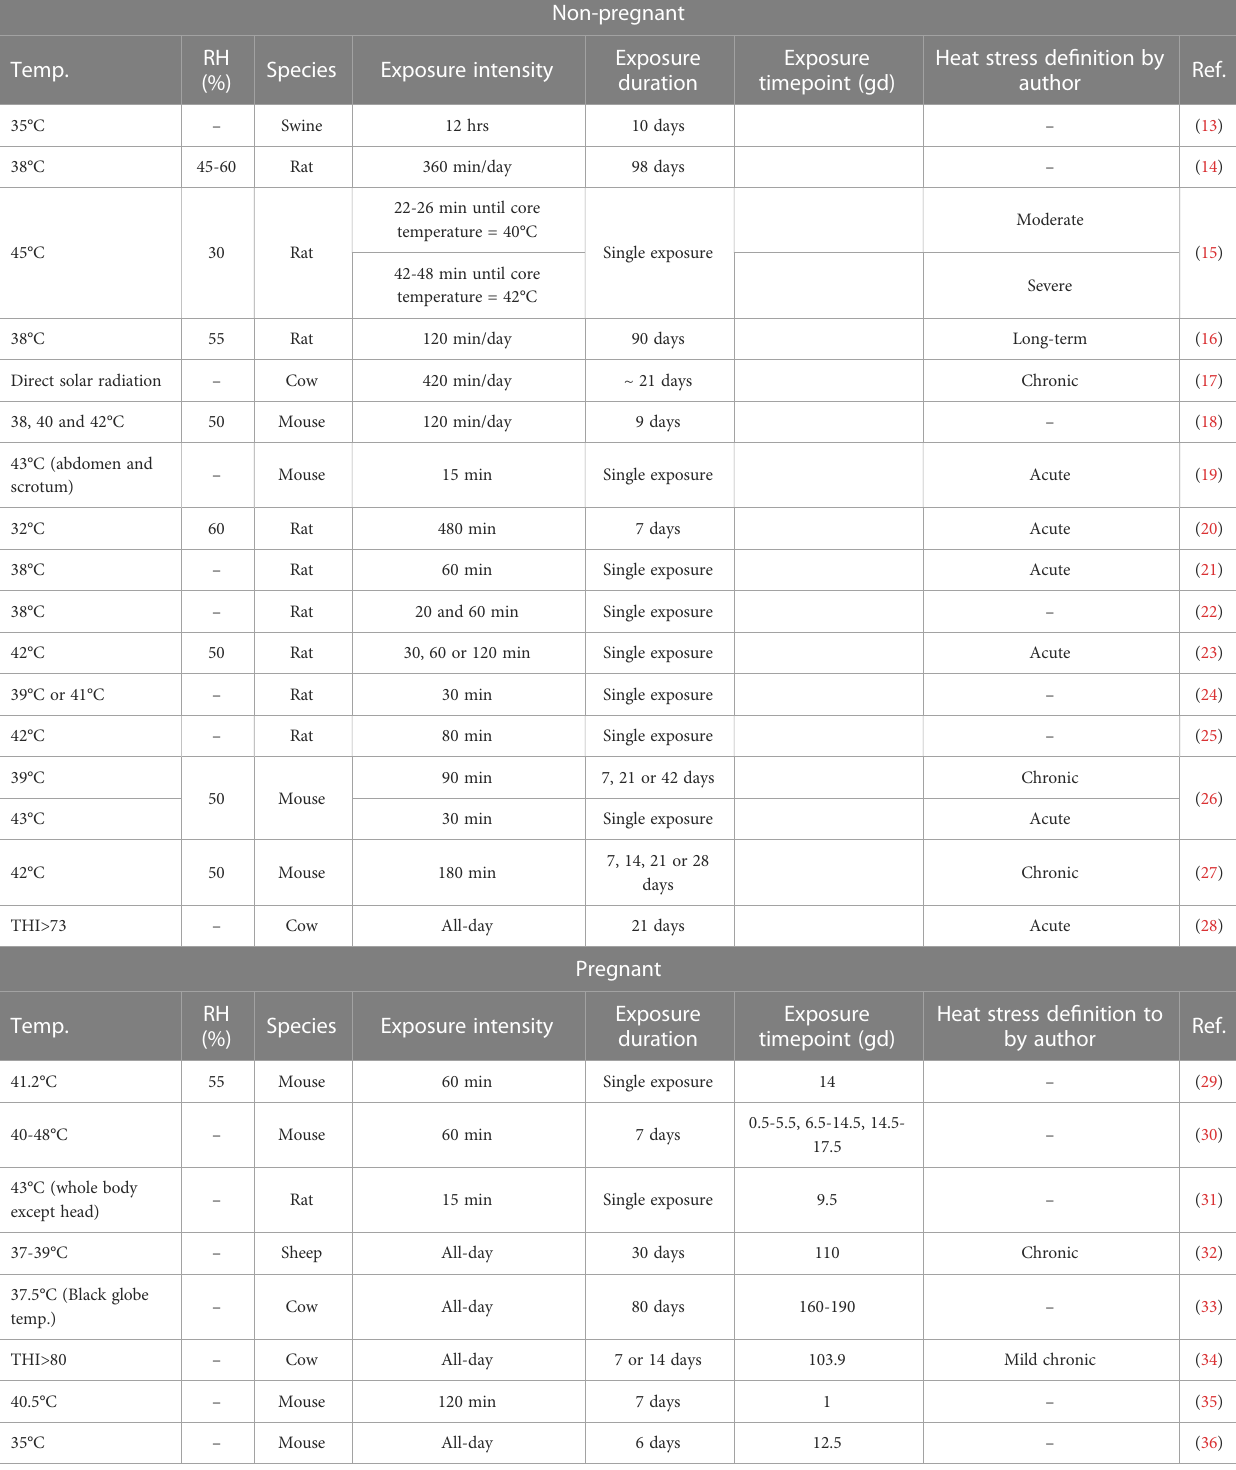
TABLE 1 Heat de fi nitions used in the referenced studies considering preclinical models.